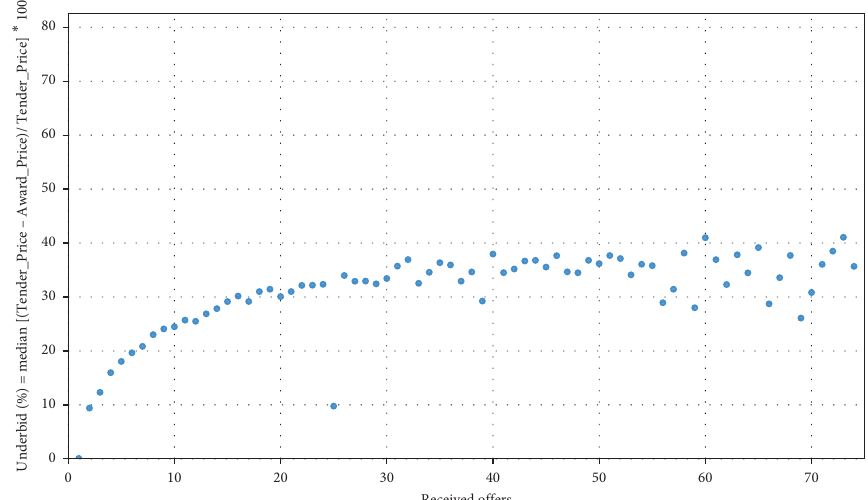
Figure 4: Relation between the received offers of bidders and the underbid (median absolute percentage error between tender price and award